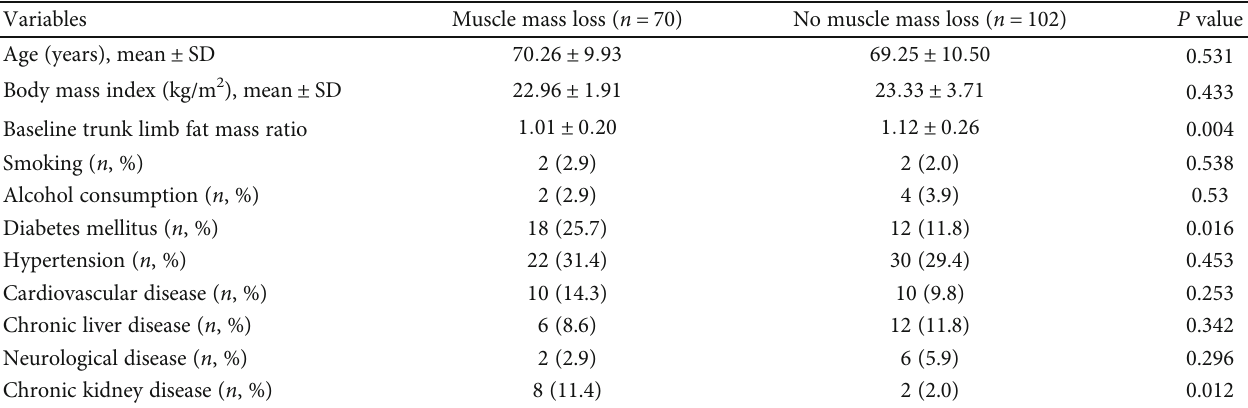
Table 1: The characteristics of the study patients.